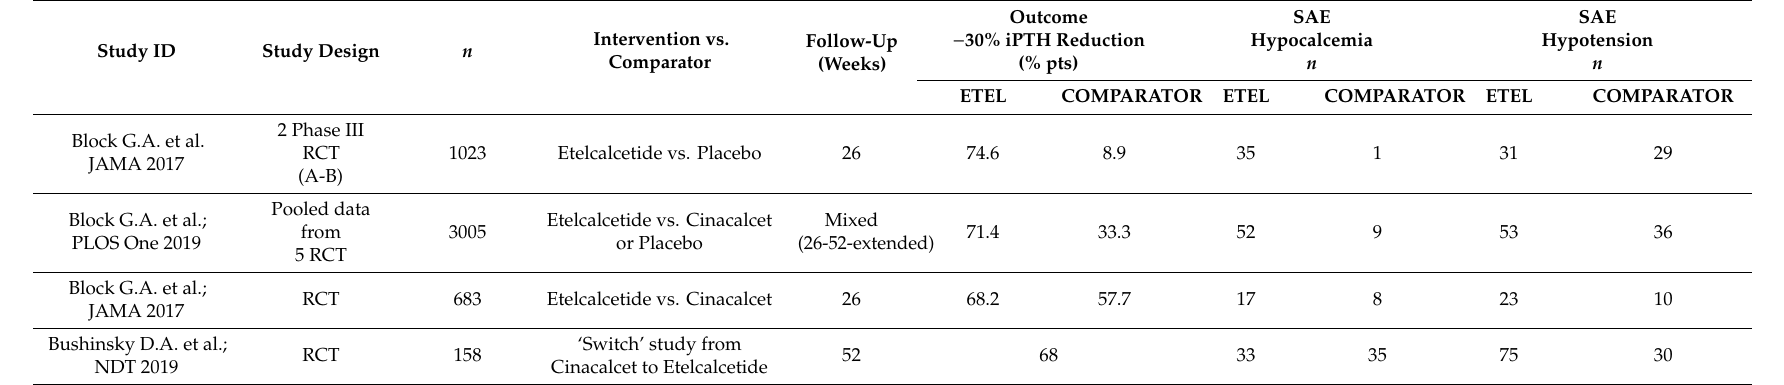
Table 1. Studies testing Etelcalcetide in comparison to placebo or Cinacalcet for SHPTH correction in hemodialysis patients in which hypotension resulted to be